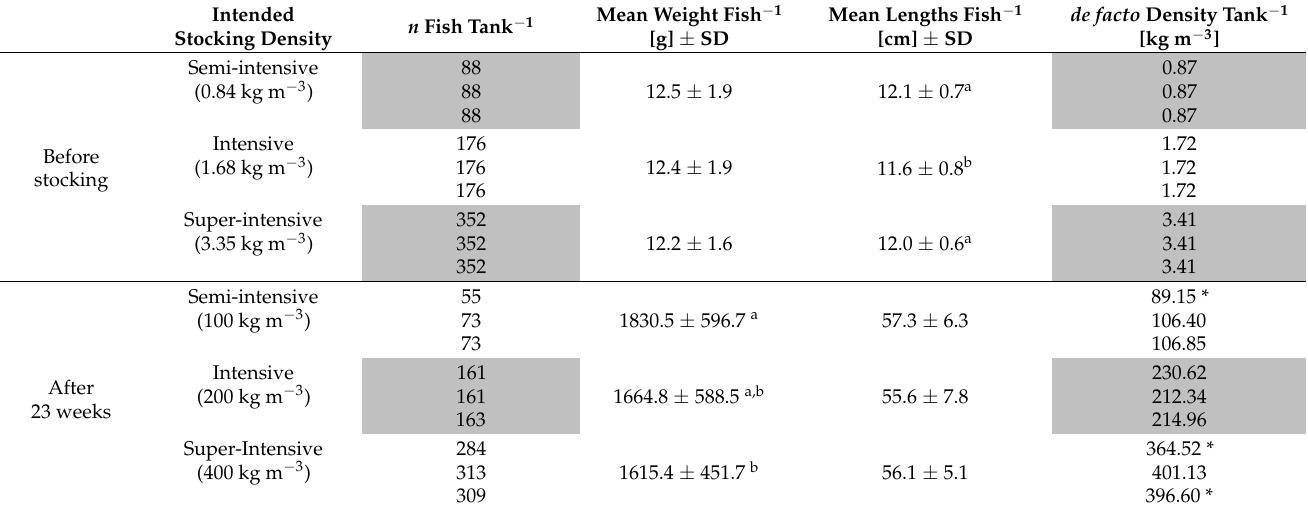
Table 2. Initial and final weights and total body lengths of African catfish (mean ± standard deviation, SD, n = 100), p > 0.05, superscripts indicate significant differences between the